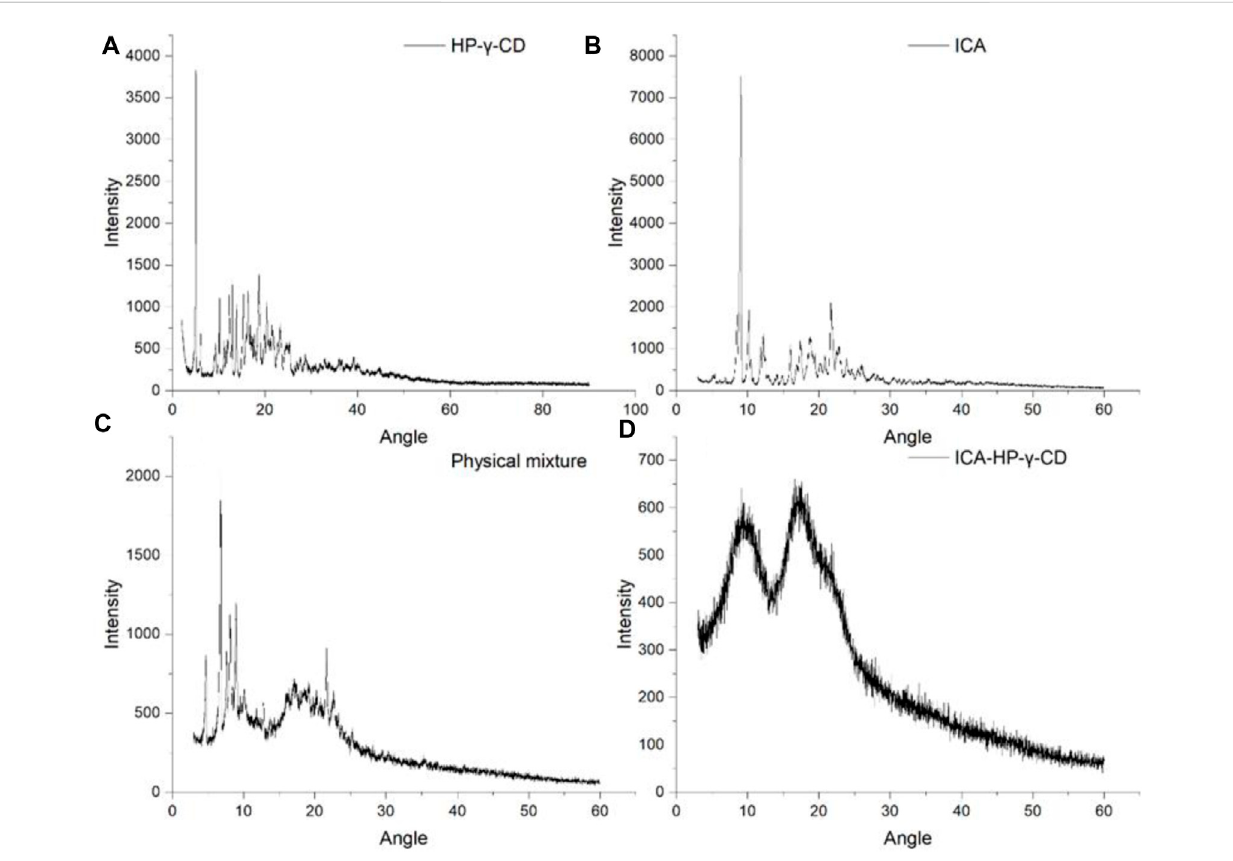
x-Ray diffraction patterns of HP- γ -cyclodextrin (A) , icariin (B) , the physical mixture of icariin and HP- γ -cyclodextrin (C) , and their inclusion complex (D)